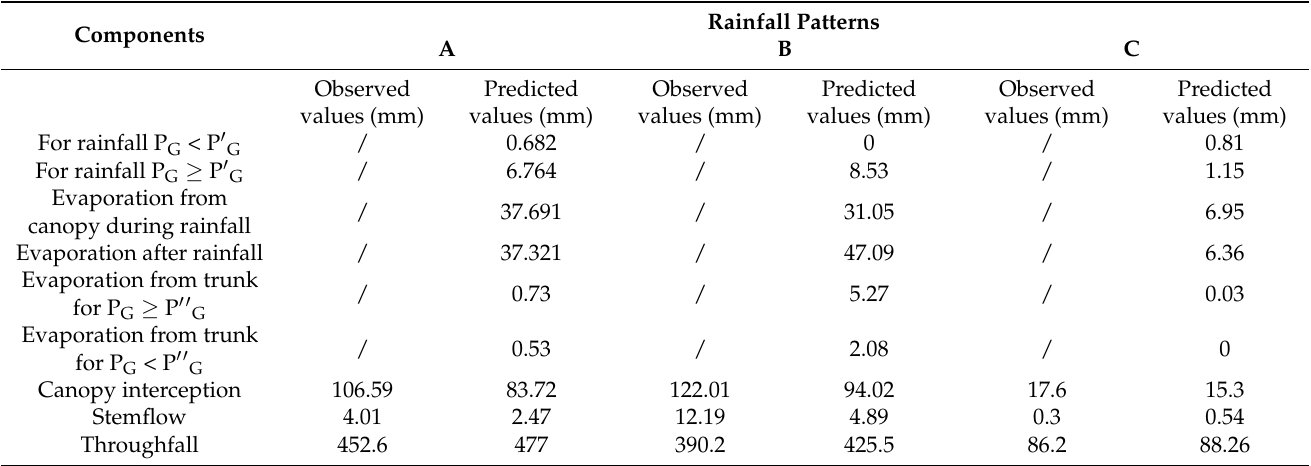
Table 5. Cumulative observed and estimated canopy water fluxes predicted by the revised Gash model.